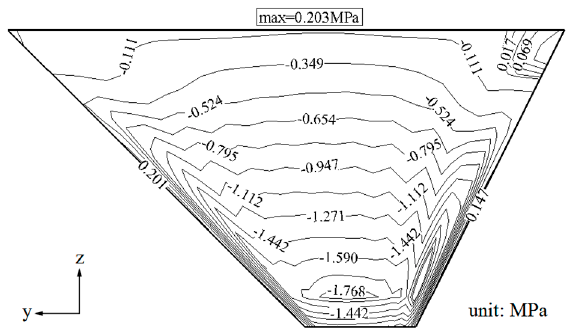
Figure 29. Major principal stress contours of CACC ( k = 0.85 × 10 − 3 ).